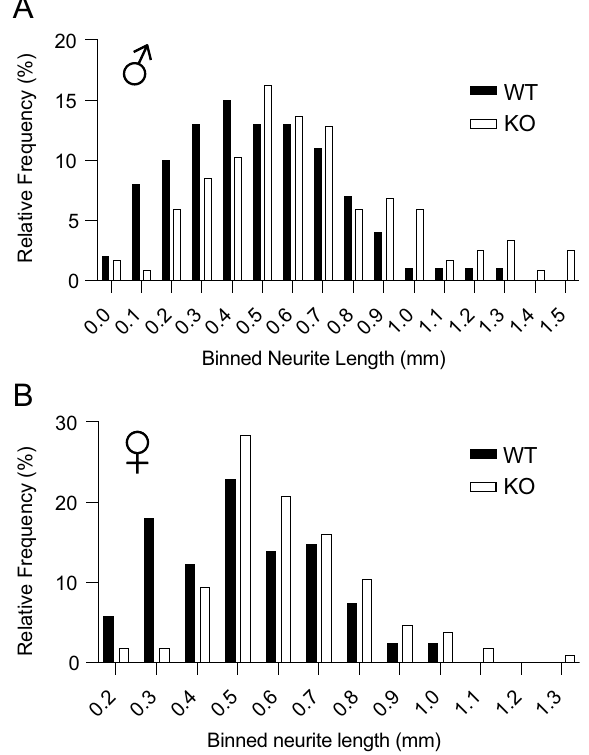
Figure 3. Caldendrin represses neurite regrowth after in vitro axotomy. DRGNs from WT and caldendrin KO mice were subject to in vitro axotomy and neurite lengths measured 1 d after replating as in Fig. 2. ( A , B ) Frequency distributions of maximal neurite lengths in cultures from male ( A ) and female ( B ) mice. Binned neurite length values represent the center of the bin. Data were collected from images of individual DRGNs (n = at least 32 images per culture, in 3 independent cultures). There was a significant difference in distributions for WT and caldendrin KO mice ( p = 0.002 for males, p = 0.001 for females by Kolmogorov–Smirnov test, n = 3 mice in each